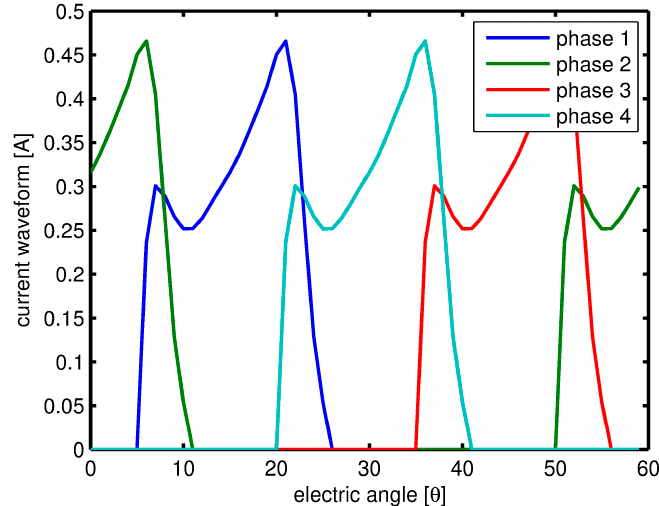
Figure 6. Current waveform for the TSF method with an exponential current waveform.